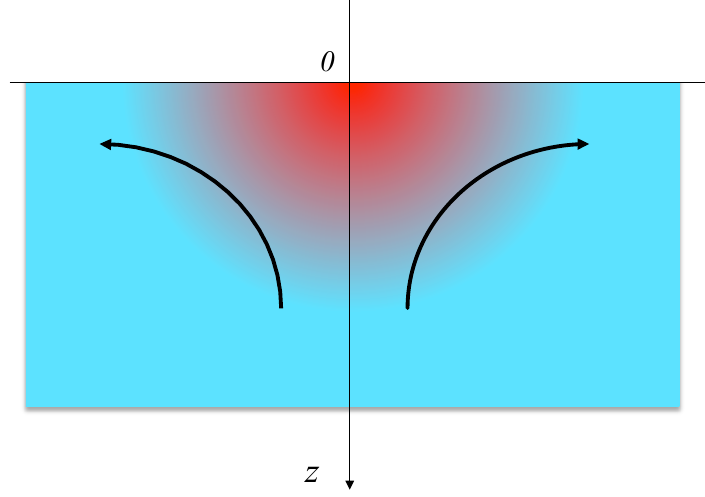
Figure 1. Schematic representation of the system. The temperature gradient induces horizontal stresses that drive the fluid from the hot to the cold areas of the interface. The z -axis is oriented